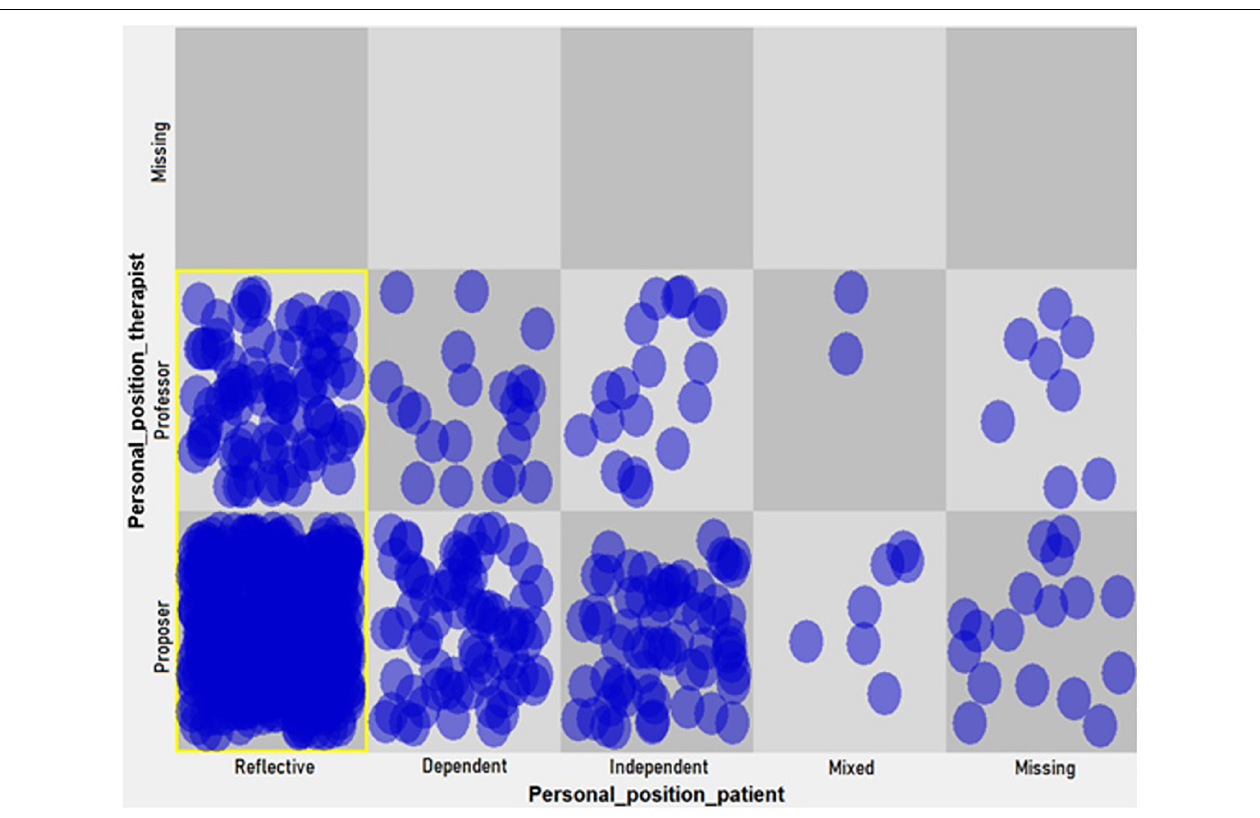
FIGURE 3 | Dynamic pattern in personal positions of the patient and her therapist (level 2, change